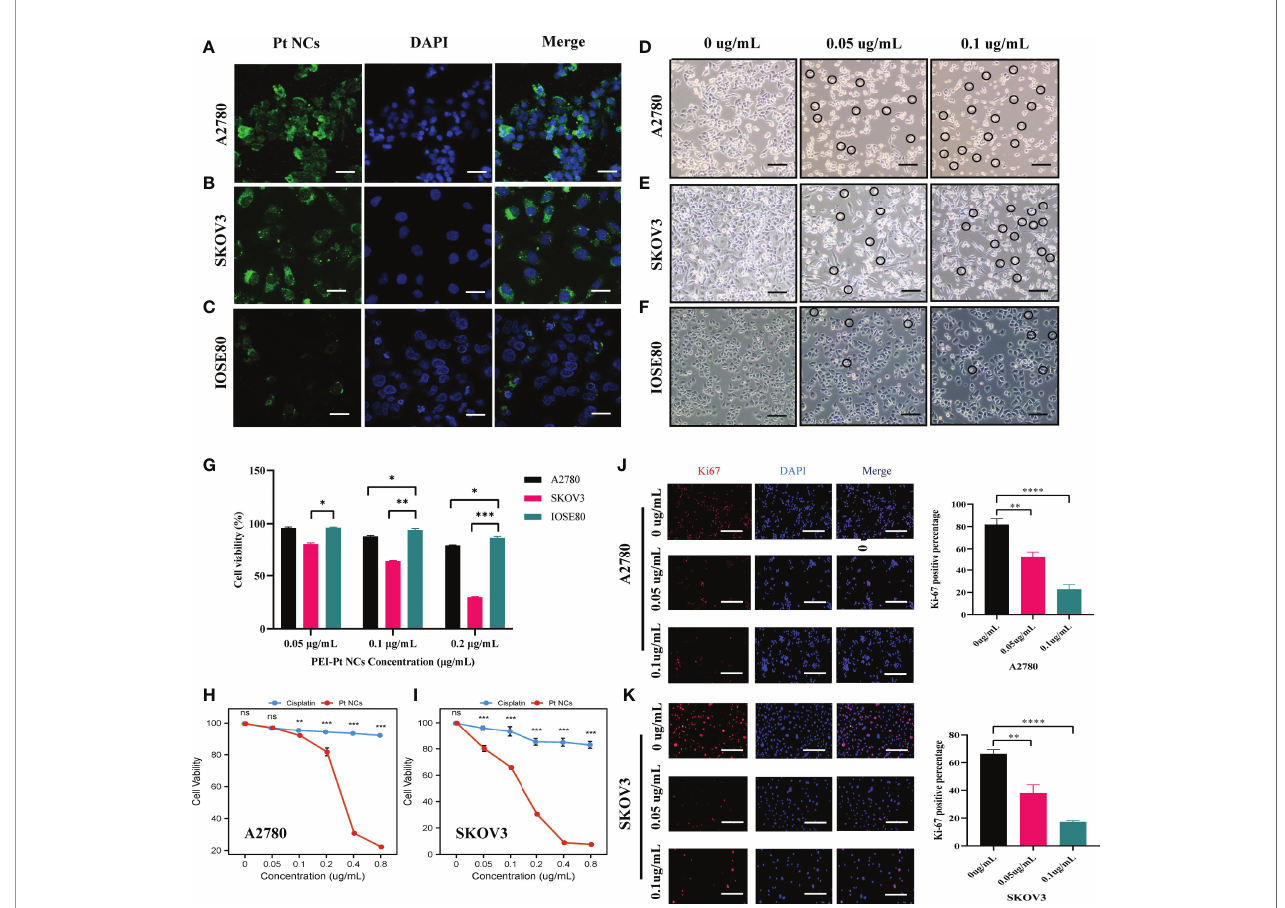
FIGURE 2 | Fields of view taken with a confocal microscope and normal microscope after PEI-Pt NCs treatment. (A-C) Confocal microscopy images of A2780SKOV3 and IOSE80 cells after co-culture with PEI-Pt NCs for 4 h. The green fl uorescence is the PEI-Pt NCs and the blue fl uorescence is the DAPI staining of the nuclei. (D-F) Morphological changes of A2780SKOV3 and IOSE80 cells after co-culture with different concentrations of PEI-Pt NCs for 24 h under a general microscope. (G) Effects of different concentrations of PEI-Pt NCs on the proliferation of ovarian normal cells and cancer cells. (H-I) Effect of treatment with different concentrations of PEI-Pt NCs on the proliferation of ovarian cancer cells. (H) Statistical analysis of CCK8 test results for A2780 cell line. (I) Statistical analysis of CCK8 test results of SKOV3 cell line. Cells were treated with 0ug/mL, 0.05ug/mL, 0.1ug/mL, 0.2ug/mL, 0.4ug/mL and 0.8ug/mL concentration gradients of cisplatin and PEI-Pt NCs. (J-K) Ki67 immuno fl uorescence staining images and statistical images of A2780 and SKOV3 cell lines treated with different concentrations of PEI-Pt NCs. Ki67 staining is red, DAPI nuclear staining is blue, and Merge is the merged image. Histograms were counted for the number of Ki67 cells. (*p < 0.05, **p < 0.01, ***p < 0.001, ****p